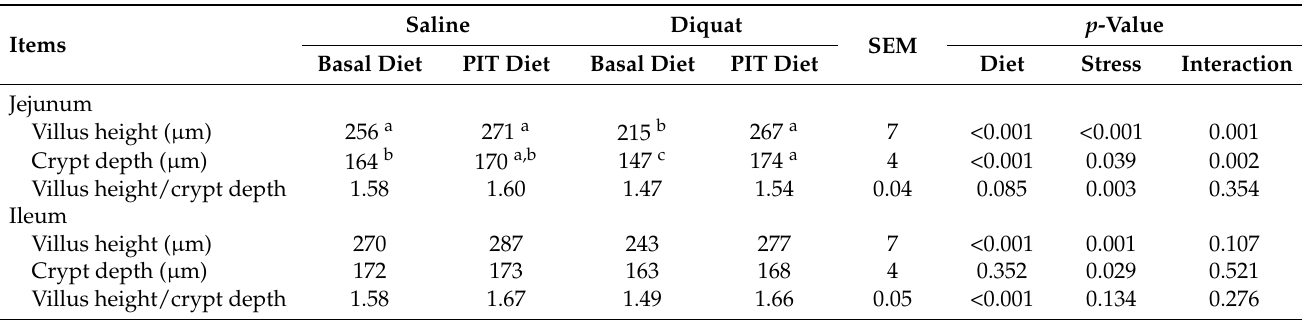
Table 3. The intestinal mucosal histology of the piglets fed polyphenols sourced from Ilex latifolia Thunb. (PIT) diets under oxidative stress.